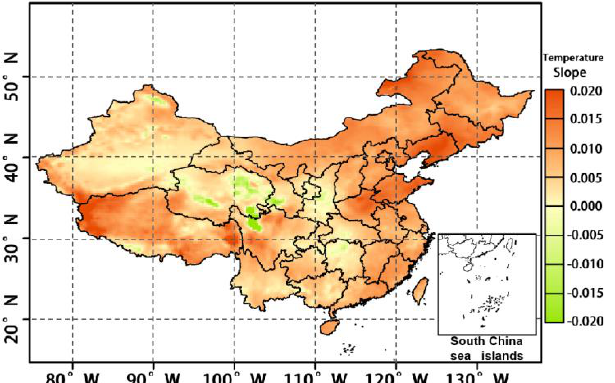
Figure 13. The 1000 hPa temperature distribution in the lower troposphere from 2008 to 2020.